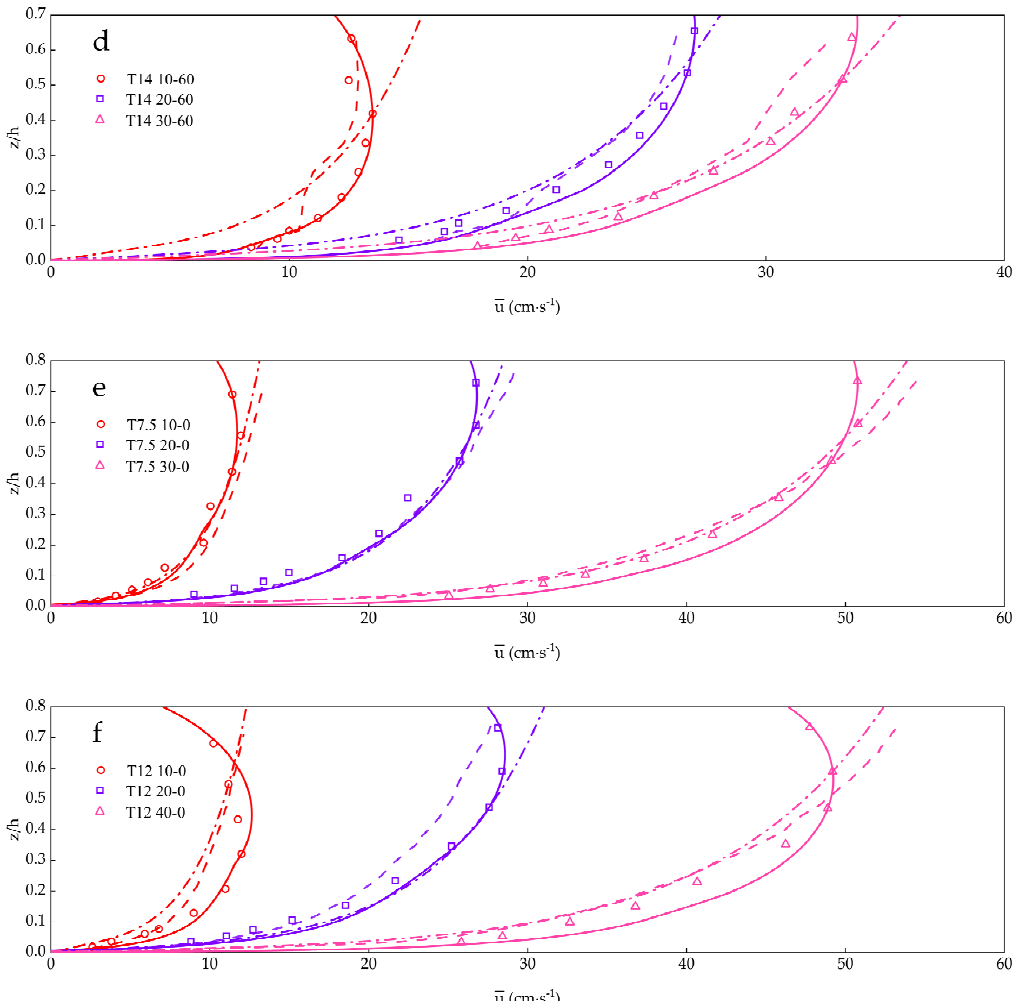
Figure 7. Comparison of the present model, the SG2017 model, and the laboratory measurements. For example, T7 10-90 represents a laboratory experiment with a wave height of approximately 7 cm, a current velocity of approximately 10 cm/s and ϕ cw = 90 ◦ . Scatters are the laboratory measurements in combined wave-current flows, the straight lines represent the calculated results of the present model, the dot-and-dash lines represent the calculated results of the SG2017 model, and the dashed lines are the lab measurement in pure currents. ( a – d ) Comparison of the present model with Havinga [46]; ( e , f ) comparison of the present model with van der Kaaij and Nieuwjaar [44]. Table 4. Comparison of accuracy of the present model and the SG2017 model in calculating current velocity. The Present Model SG2017 EXP.